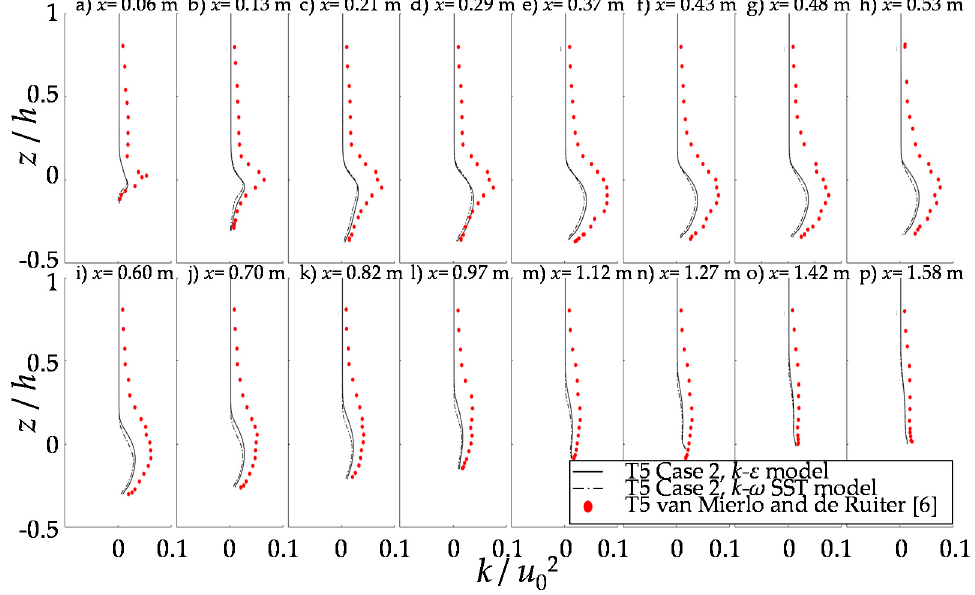
Figure 5. Comparison of di ff erent turbulence schemes in nondimensional turbulent kinetic energy Figure 5. Comparison of different turbulence schemes in nondimensional turbulent kinetic energy (TKE) with experimental data for Case 2 ( k s = 1.6 D 50 Figure 5. Comparison of different turbulence schemes in nondimensional turbulent kinetic energy (TKE) with experimental data for Case 2 ( 𝑘 (cid:3046) = 1.6𝐷 (cid:2873)(cid:2868) ). (TKE) with experimental data for Case 2 ( 𝑘 (cid:3046) = 1.6𝐷 (cid:2873)(cid:2868) ).